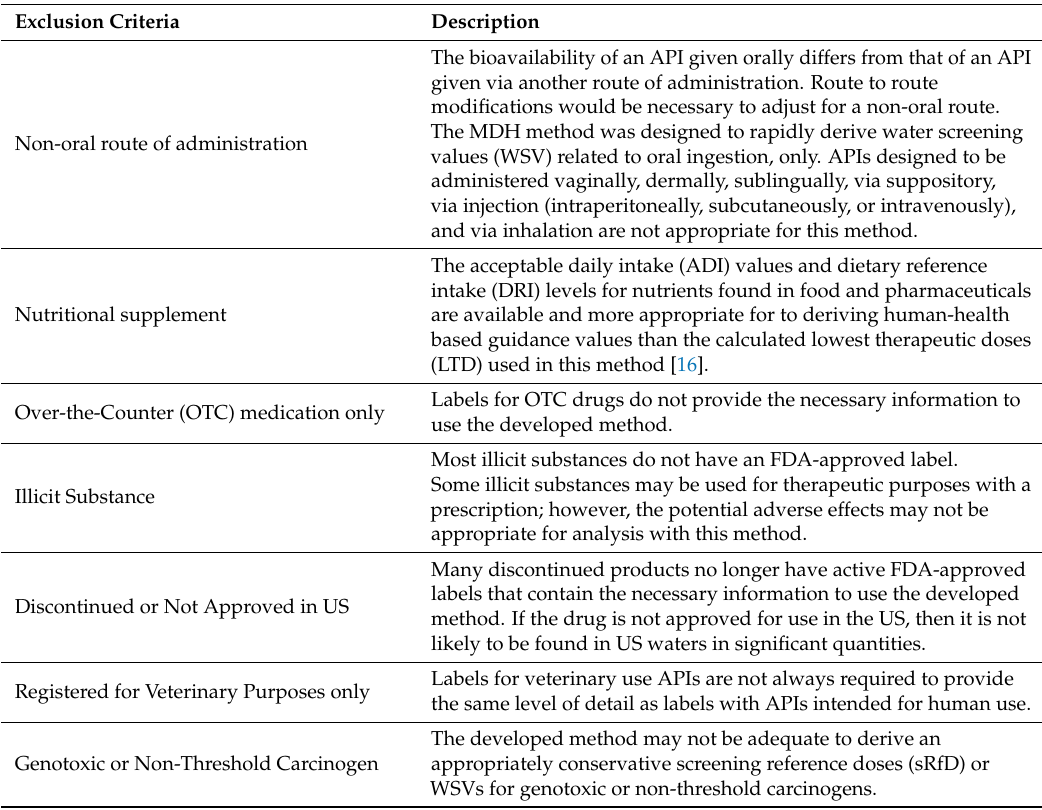
Table 1. Exclusion Criteria for Applicable